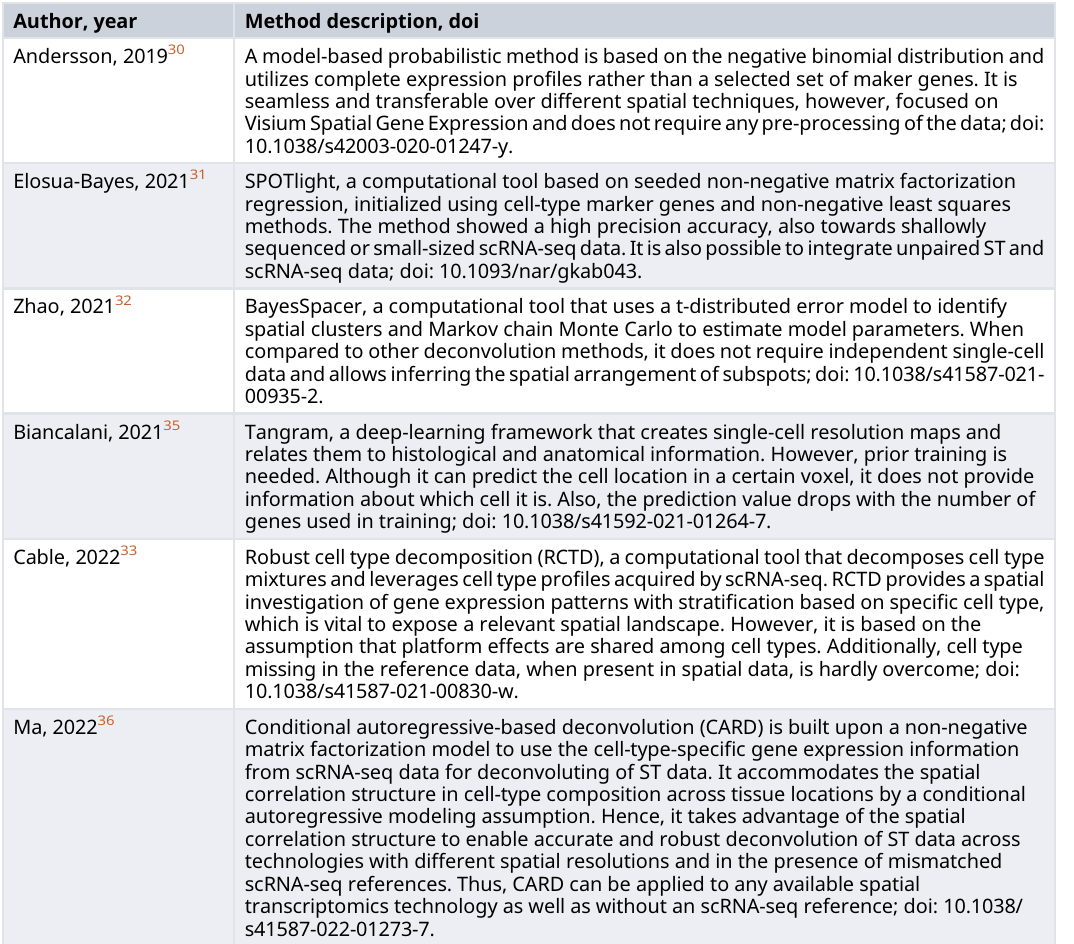
Table 1. Methods of deconvolution of single-cell RNA sequencing and spatial transcriptomics. Author,